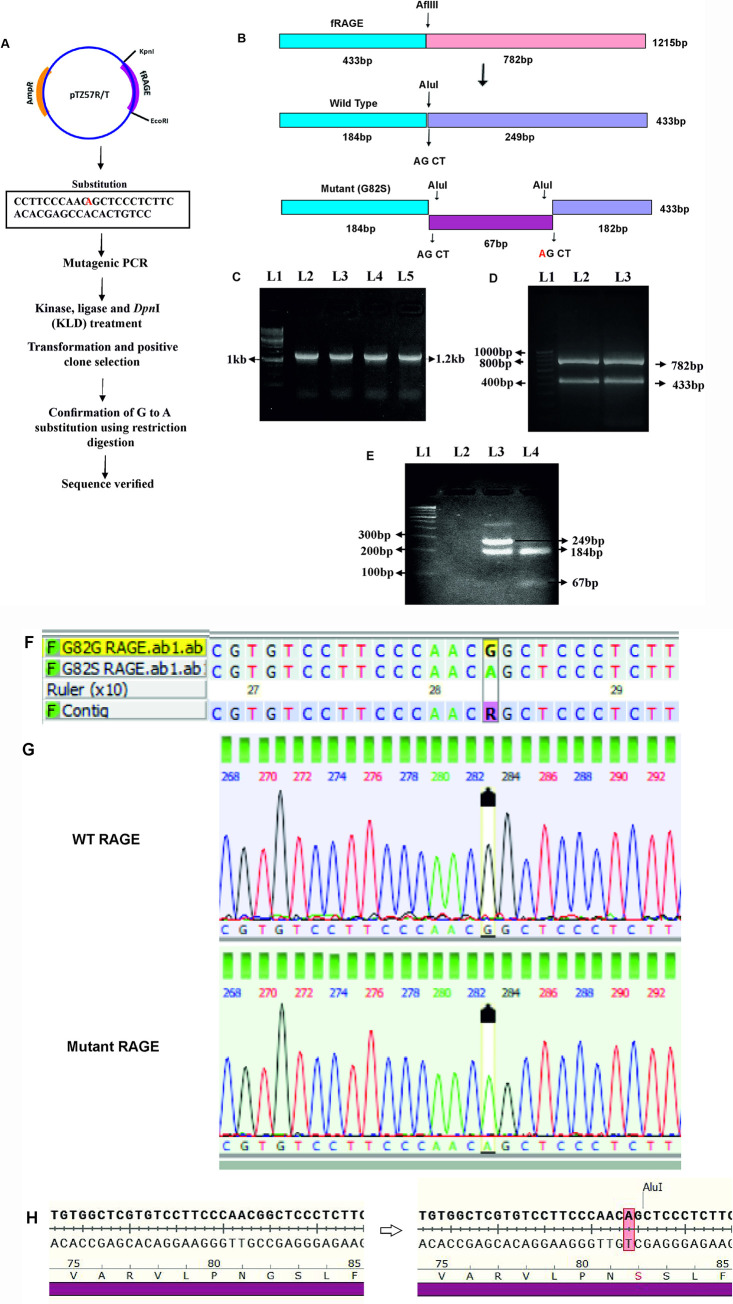
Site directed mutagenesis of RAGE gene and mutation confirmation by restriction profiling and sequencing.A) Schematic representation of site directed mutagenesis performed in pTZ57R/T RAGE construct. B) Restriction Mapping of WT & mutant RAGE with AflIII and AluI enzyme. C) Amplification of WT & mutant RAGE gene. L1-1kb DNA ladder, L2 & 3 –WT RAGE PCR product, L4 & 5 –Mutant RAGE PCR product. D) Restriction profile of AflIII digested fRAGE gene PCR product. L1- 100bp step up DNA ladder, L2- AflIII digested WT RAGE gene PCR product, L3- AflIII digested mutant RAGE gene PCR product. E) Restriction profiling of WT and mutant RAGE gene. L1-100bp step up DNA ladder, L2- empty, L3- AluI digested WT RAGE gene fragment, L4- AluI digested mutant RAGE gene fragment. F) Sequence confirmation of mutation in RAGE gene. Top row represents wild type nucleotide sequence and bottom row represent the mutant type sequence (G mutated to A in RAGE gene). G) Sequence chromatogram of WT and mutant RAGE sequence obtained from DNA baser assembler software. Red boxes highlight the sequencing location of the RAGE gene with G>A nucleotide change resulting in a G82S mutation. H) Representation of nucleotide change from G to A in RAGE gene which results in amino acid mutation at 82 position from Gly to Ser.